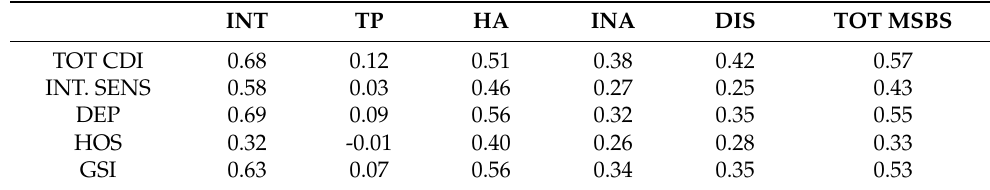
Table 8. Pearson’s r correlations between factors of the MSBS and the other tools, considering the sample as a